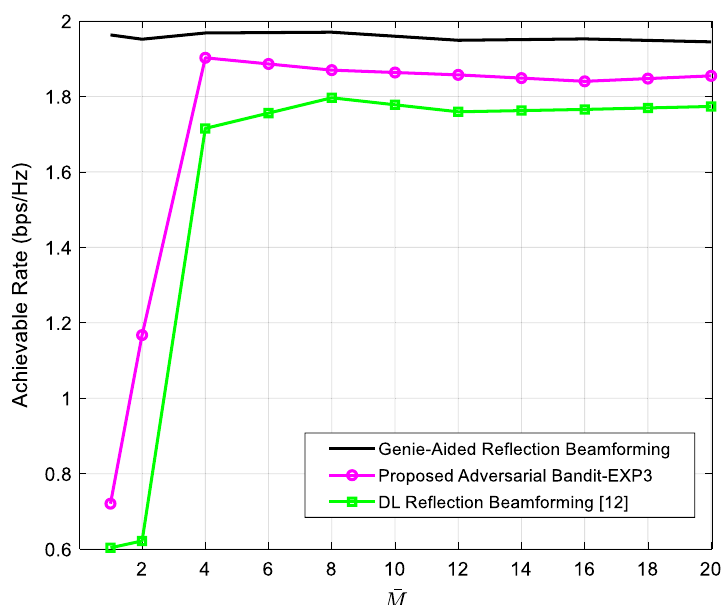
Fig. 4 The achievable rate versus the number of active elements of the proposed EXP3-based scheme in comparison with the reference DL reflection beamforming [26] and the reference genie-aided method (that assumes perfect knowledge of the channel) where the number of training data is set to 30